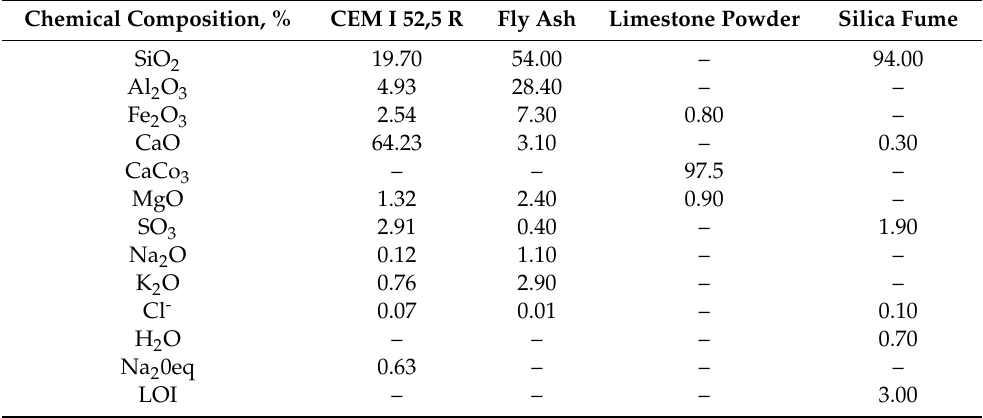
Table 2. Chemical composition of Portland Cement, Fly Ash, Limestone powder and Silica Fume.